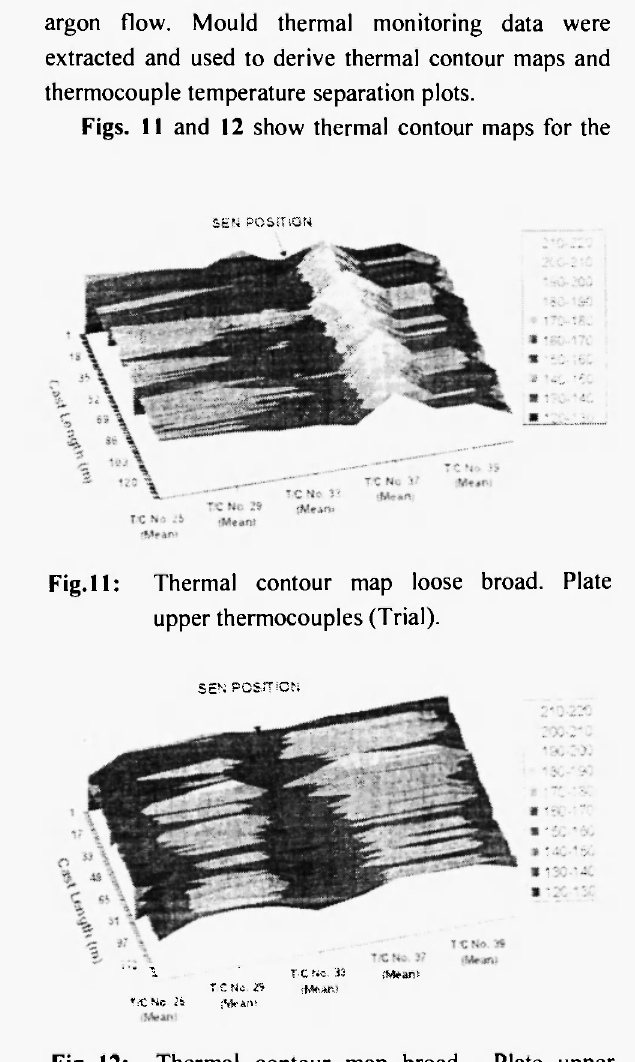
Fig. 12: Thermal contour map broad . Plate